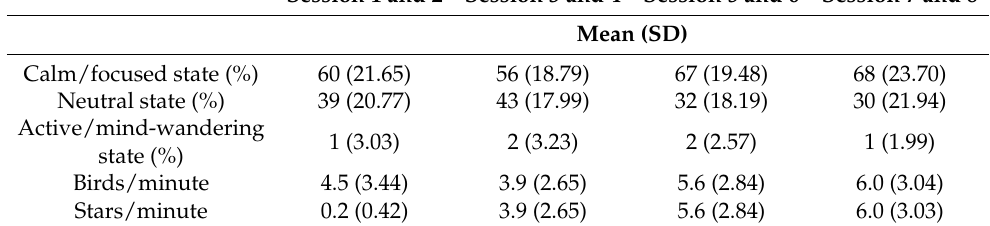
Table 3. Within-group changes in brain states during the mindfulness sessions with EEG-feedback ( n =